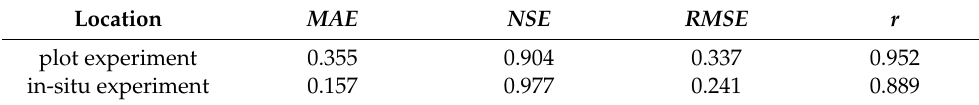
Figure 3. Dynamic curve and relationship between observed daily evaporation and calculated results (on the left is a comparison between the calculated and observed values of the plot experiment; on the right is a comparison between calculated and observed values in the reservoir in-situ experiment). Table 1. Calculation accuracy of energy balance